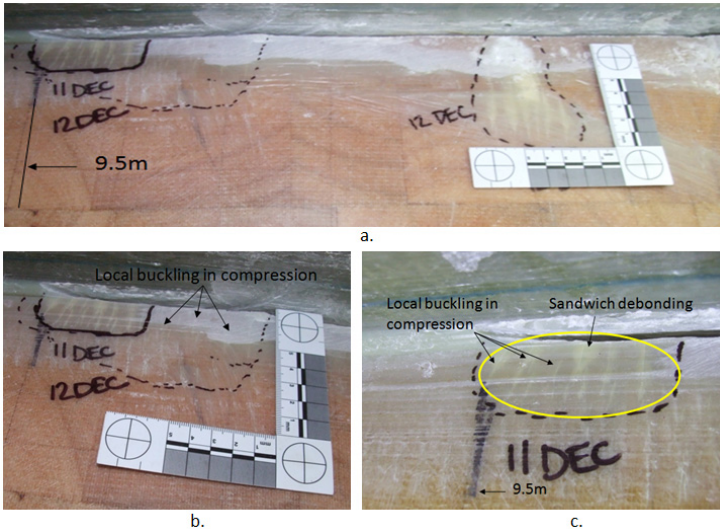
Figure 16. Outside web at 9.5 m ( a ) overview of local buckling under compression and sandwich